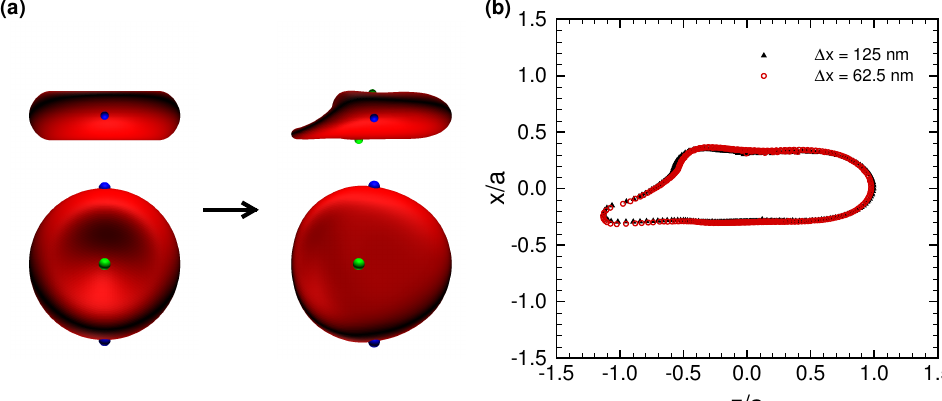
Figure 2. ( a ) Typical snapshots of a deformed RBC subjected to Ca = 0.15 at the initial state (left) and steady state (right). Two views, from the span-wise and stream-wise directions, are shown above and below, respectively. The markers represent node points. ( b ) Superposition of the fully deformed RBC projected on the x - z plane at Ca = 0.15 . The two lines obtained with ∆ x = 125 nm (black) and 62.5 nm (red), respectively. The membrane position is normalized by the reference radius a